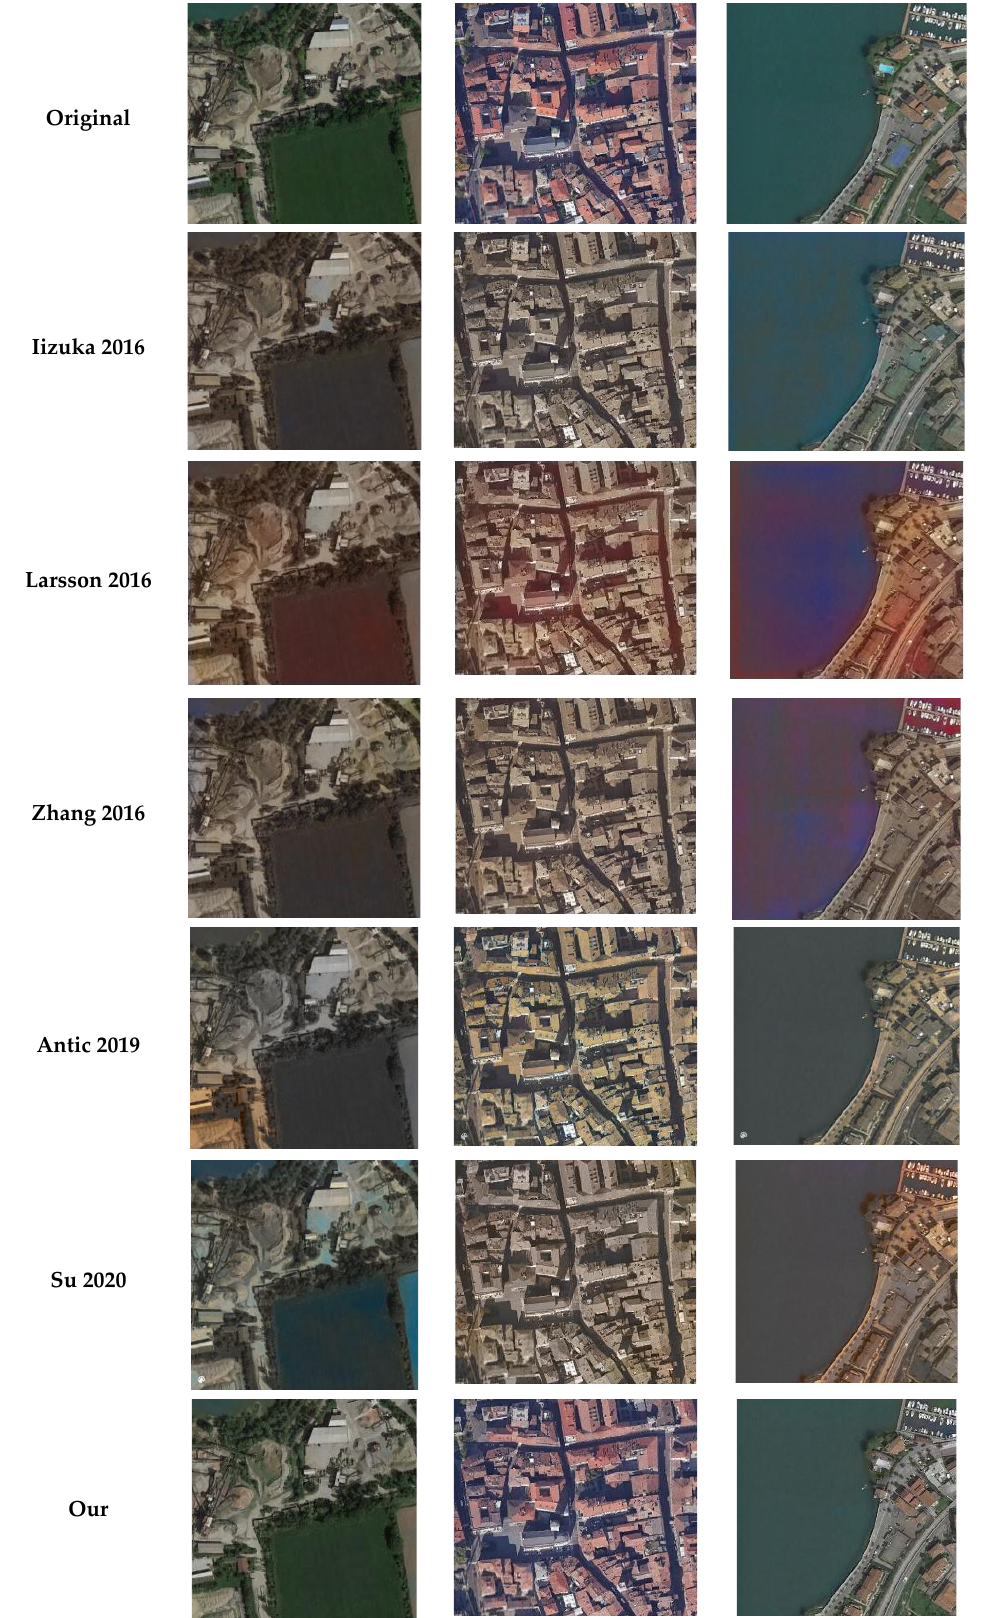
Figure 7. Some colorization outputs, comparing the proposed Hyper-U-Net method with state-of- the-art methods on actual aerial images converted into grayscale.